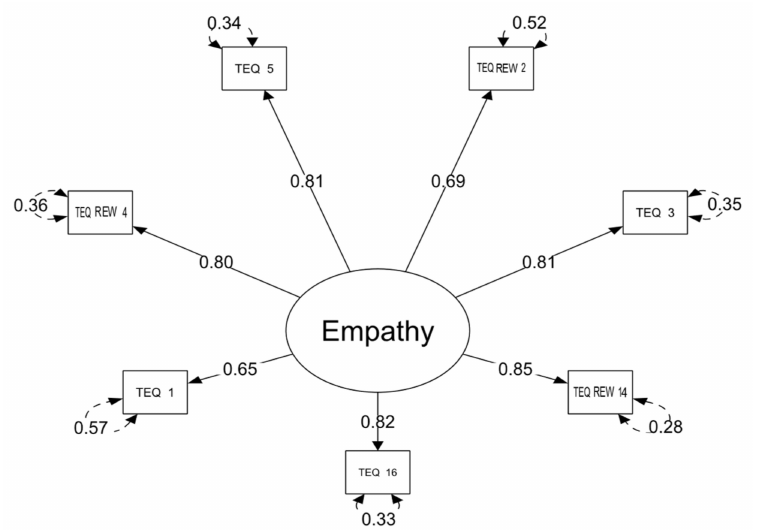
Figure 2. The General empathy model of TEQ with factor loadings and residuals (Study 2, n = 1036). The “REW” in item 2, 4 and 14 refers to positively reformulated negative